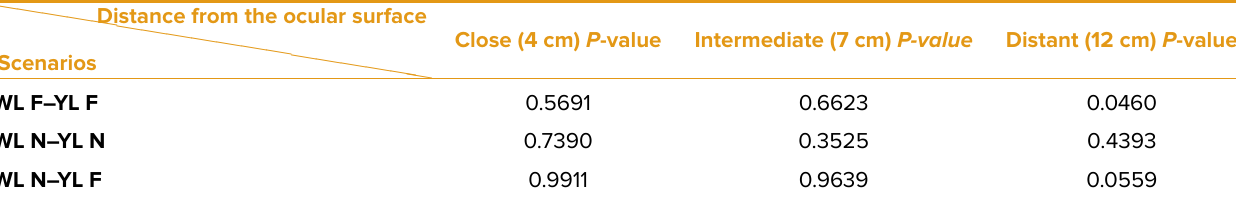
Table 2. Significance level ( p -values) difference in bleb areas using ANOVA test in different lighting